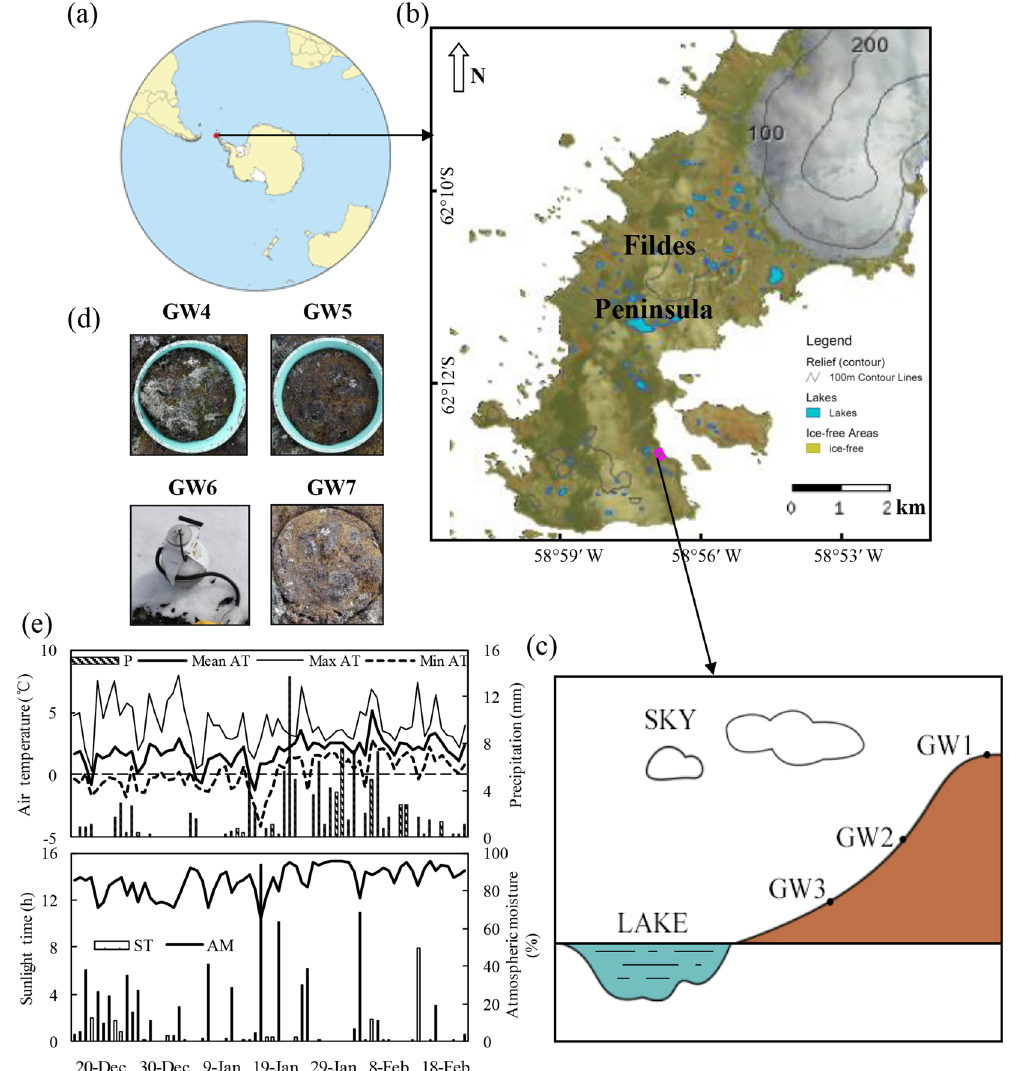
Figure 1. ( a ) The dot indicates location of the investigation area in maritime Antarctica. ( b ) Location of the study sites in Fildes Peninsula. ( c ) The position of the investigation sites GW1, GW2 and GW3 in upland tundra of Fildes Peninsula; ( d ) The background of the sites GW4, GW5, GW6 and GW7; ( e ) The climate conditions during tundra ER measurements. Note: The map was drawn using CorelDRAW 2017